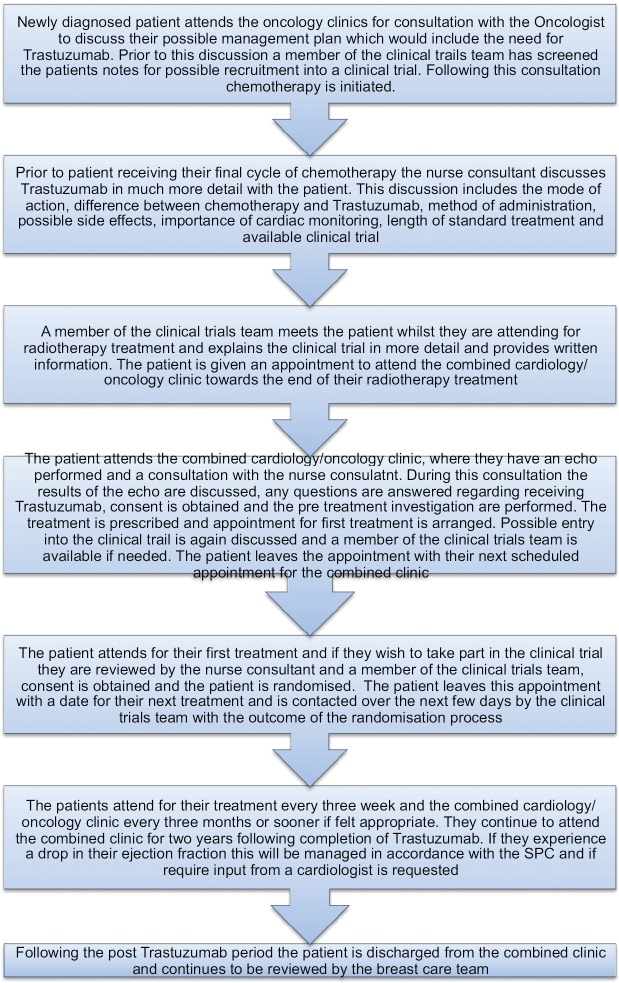
Patient pathway.